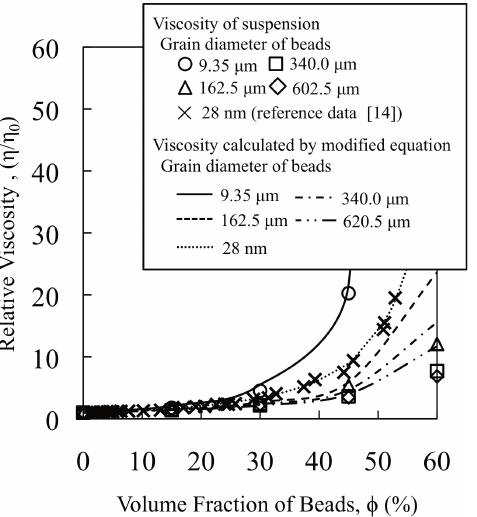
Figure 6. Comparison of the corrected Einstein–Roscoe equation with the measured value at shear rate 0.048 s (cid:3) 1 and the reference data at shear rate 400 s (cid:3) 1